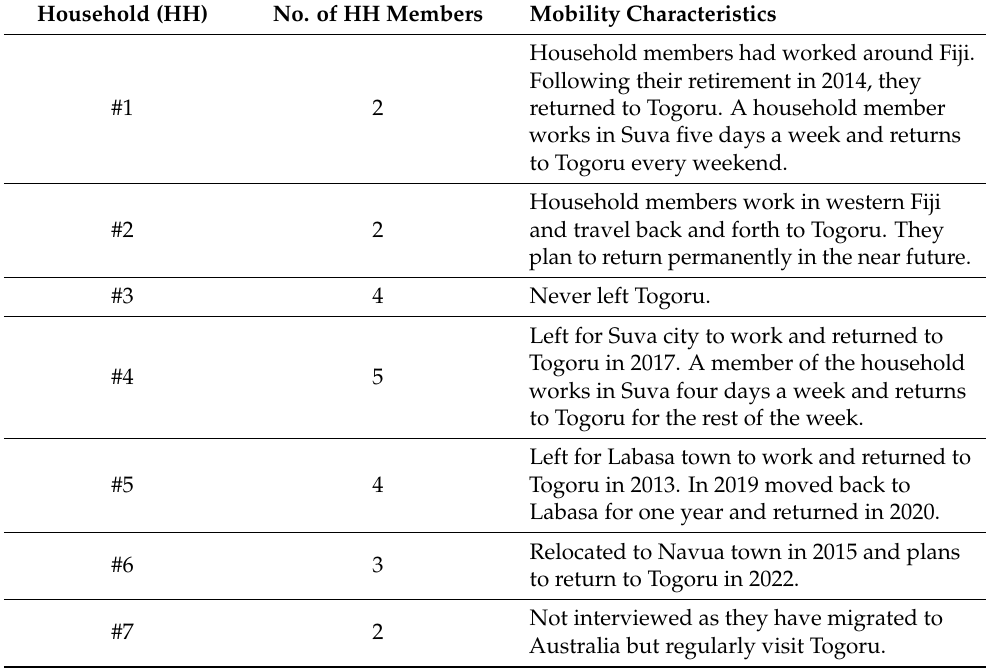
Table 1. Summary of household mobility characteristics in